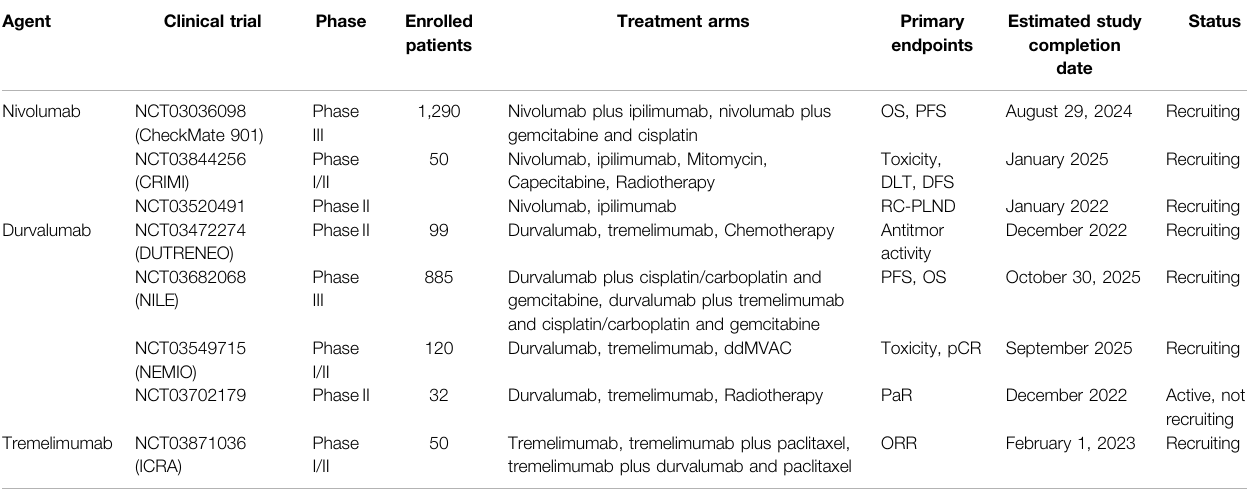
TABLE 4 | Ongoing clinical trials ’ information of CTLA4 inhibitors in patients with